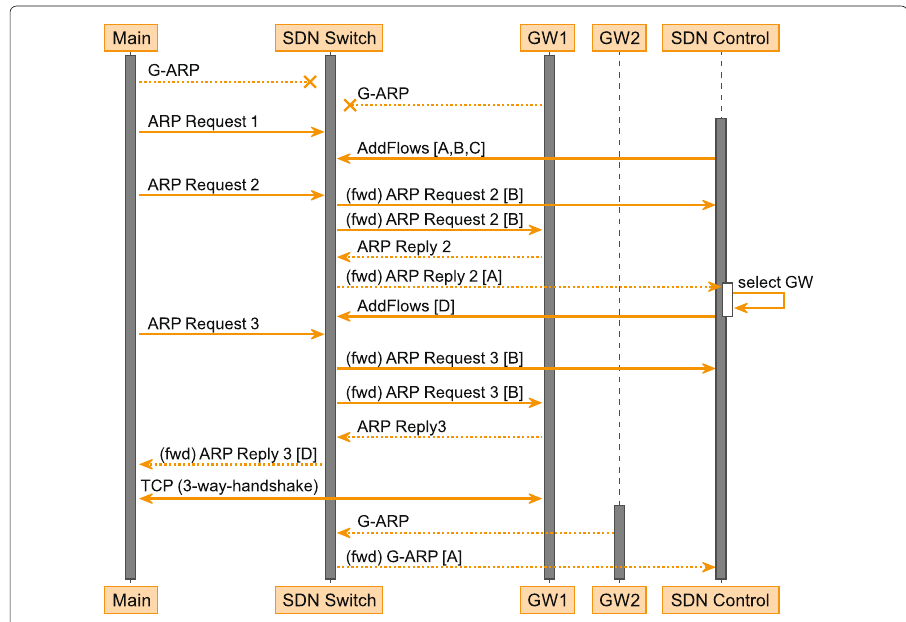
Fig. 5 The sequence diagram shows the second case using ARP messages for connection establishment. As intended, finally Main and GW1 establish the 104/TCP connection